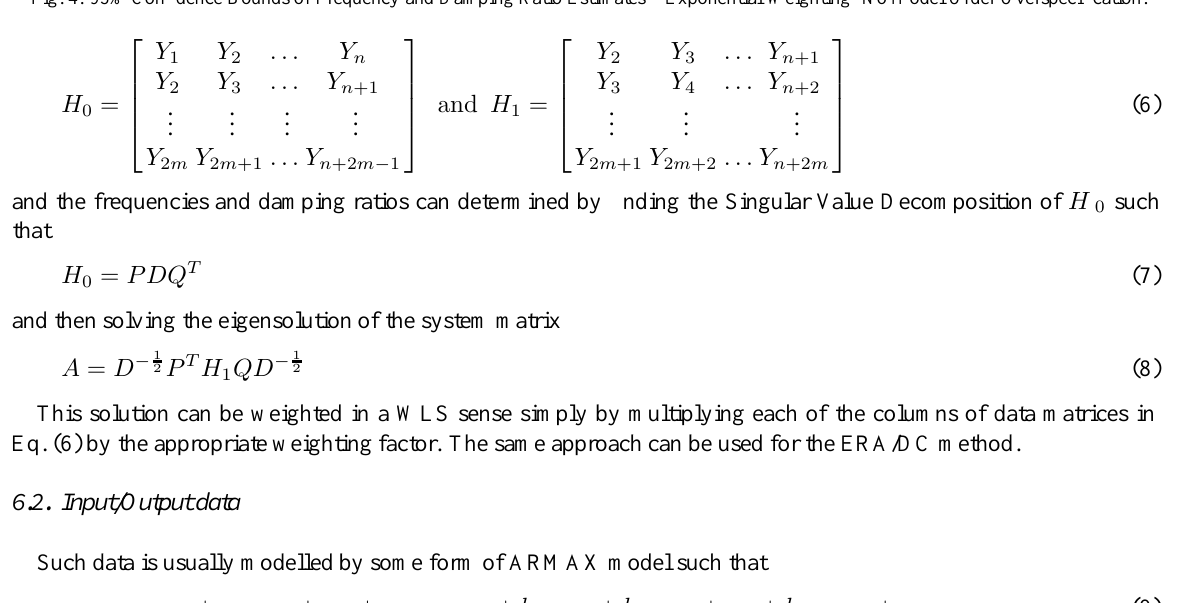
Fig. 4. 95% Confidence Bounds of Frequency and Damping Ratio Estimates – Exponential Weighting- No Model Order Overspecification.